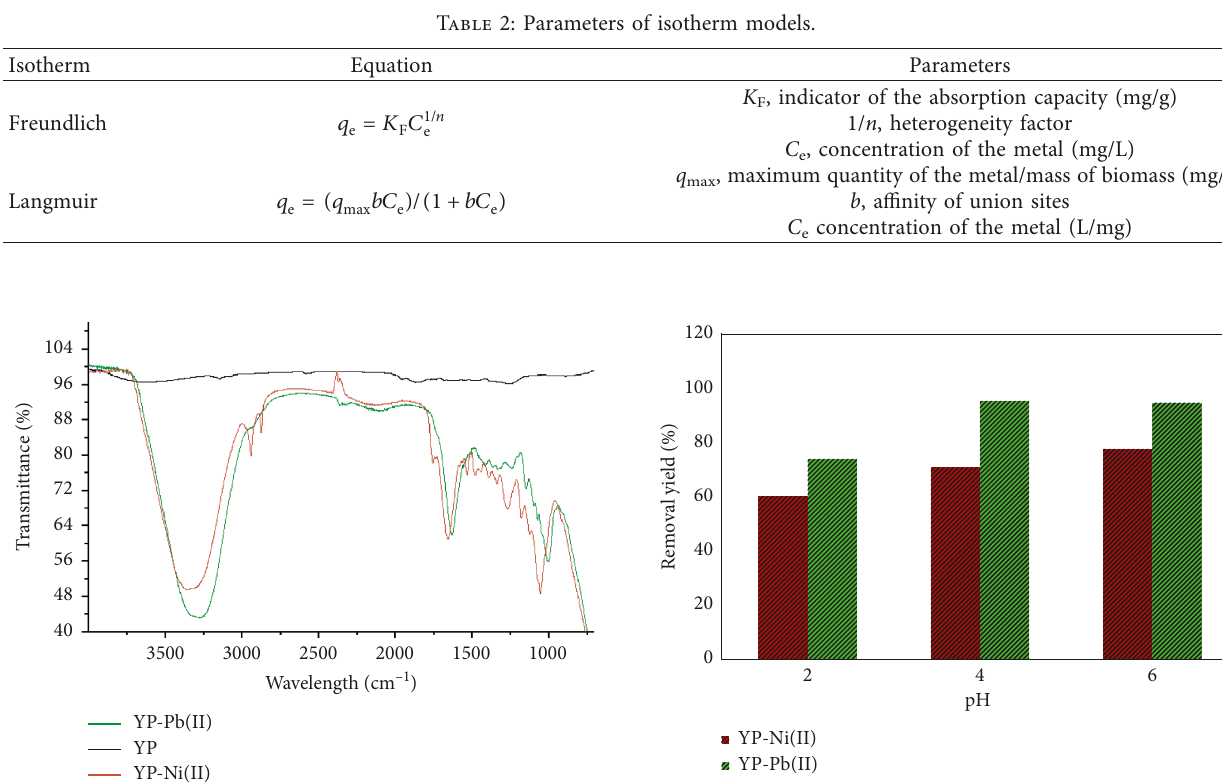
Figure 2: Influence of solution pH on yam peels removal yield.